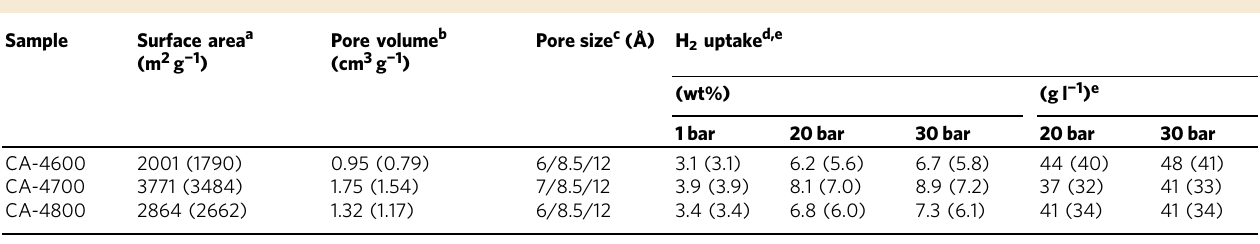
Table 2 Textural properties and H 2 uptake of cellulose acetate-derived activated carbons Sample